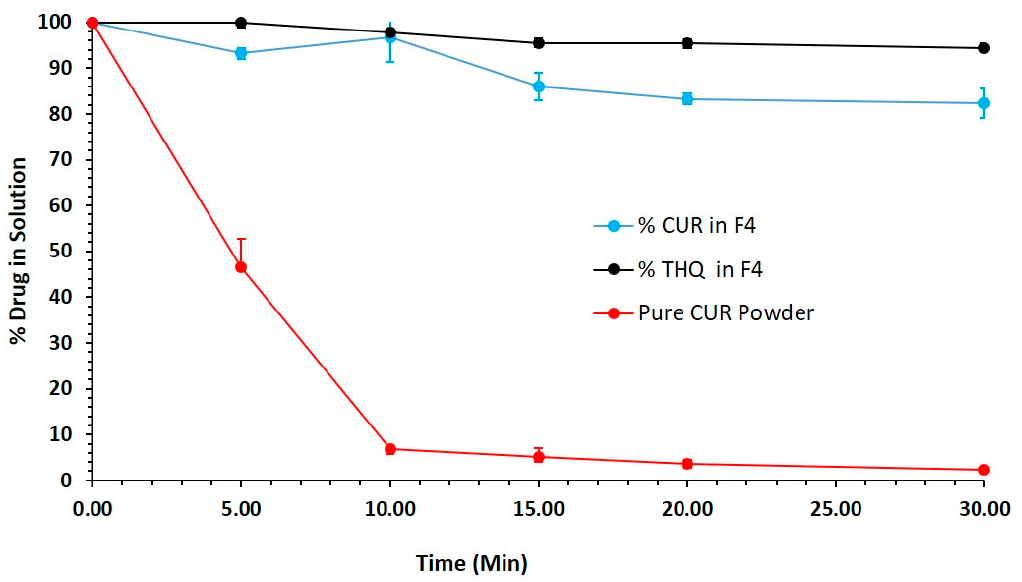
Figure 8. Percentage of the drug dose in solution in the presence of pancreatic lipase from the representative Bio-SNEDDS formulation (F4-BSO / I988 / KolliphorEL (35 / 15 / 50 % w / w )), which contains CUR and THQ in a combined dosage form in FeSSIF solution during the in-vitro digestion experiment at various time intervals within a 30-min reaction period.